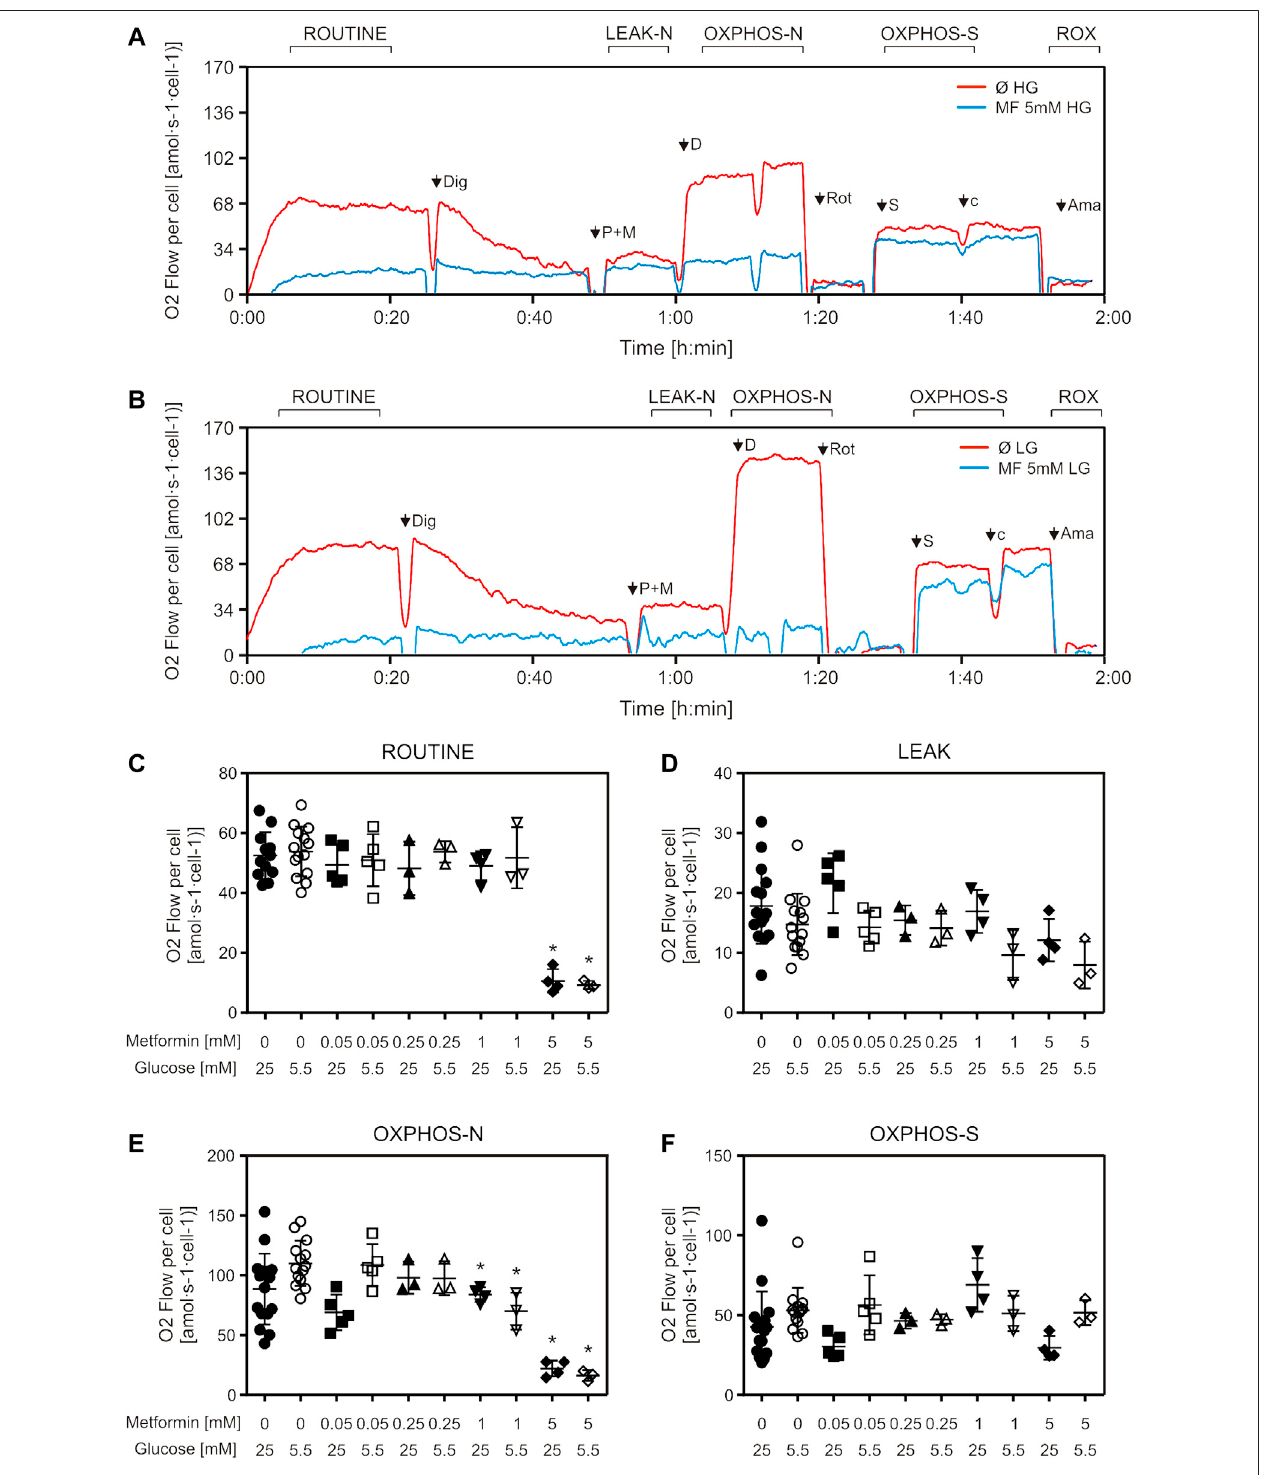
FIGURE 2 | Mitochondrial respiration is decreased by suprapharmacological but not therapeutic metformin concentrations. C2C12 cells were treated with metformin (50 – 5000 µM) for 24 h and mitochondrial respiration of permeabilized cells was measured by high-resolution respirometry. Representative DatLab traces of untreated and 5 mM metformin treated high glucose (A) and low glucose (B) medium-cultured cells. Respiration rates of ROUTINE (C) , LEAK (D) , OXPHOS-N (E) , and OXPHOS-S (F) respiratory states, all corrected for ROX, from 3 to 5 independent experiments are presented as scatter plots, with mean ± SD, * p < 0.05. Dig — digitonin, P — pyruvate, M — malate, D — ADP, Rot — rotenone, S — succinate, cyt c — cytochrome c , Ama — antimycin A, HG — high glucose, LG — low glucose, MF — metformin, Ø — untreated control, OXPHOS-N — NADH-linked oxidative phosphorylation capacity, OXPHOS-S — succinate-linked oxidative phosphorylation